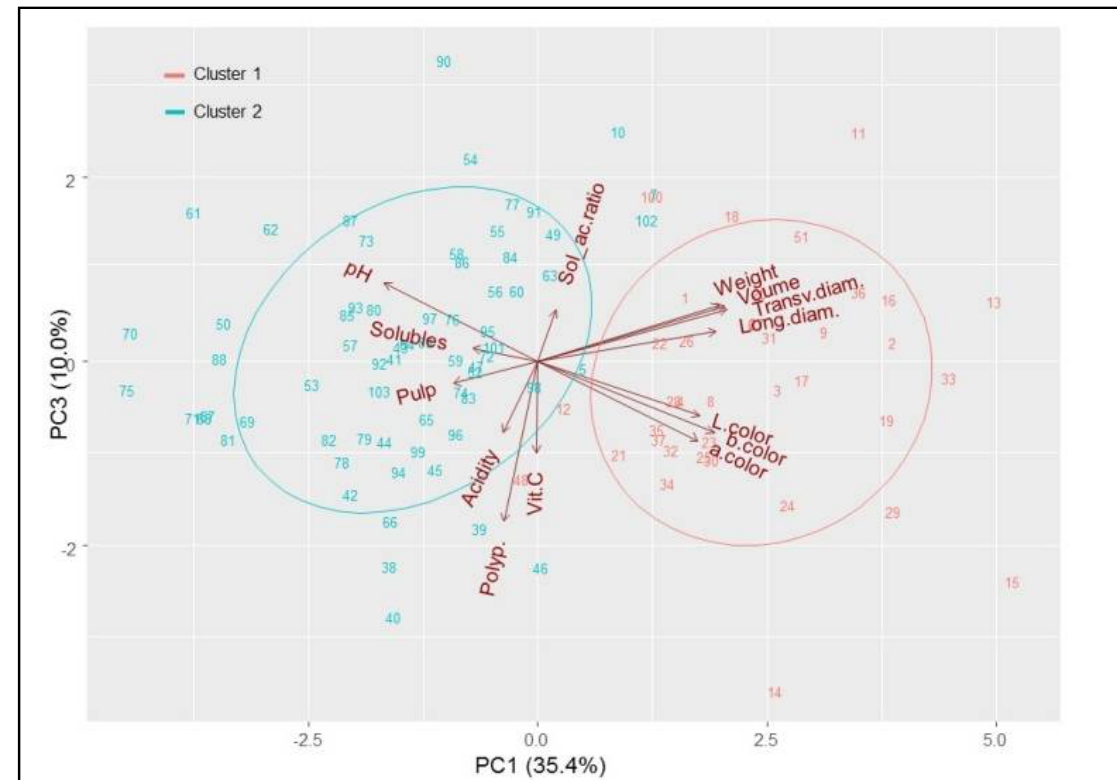
Figure 8. Scatter plot of the scores of acerola samples on the two-dimensional plane defined by PC1 and PC3 as calculated from the complete dataset by PCA. Samples are grouped according to the HCA results (the confidence level of 0.95 defines the ellipses in such manner that approximately 95% of the new observations from that group fall inside the ellipse). The two sample groups, differing by color, corresponded to the clusters defined by HCA. Almost 55% of the total variance was explained by the first two PCs and 45.4% of the total variance is explained by PC1 and PC3. The main separation between the two clusters was obtained through PC1. The descriptors contributing the most in PC1 (35.4% of the total variance) were fruit size, color parameters and pH, confirming the results of the heat map cluster analysis (Figure 6). In particular, samples from cluster 1 (red symbols) showed higher values of fruit size and color parameters. Samples from cluster